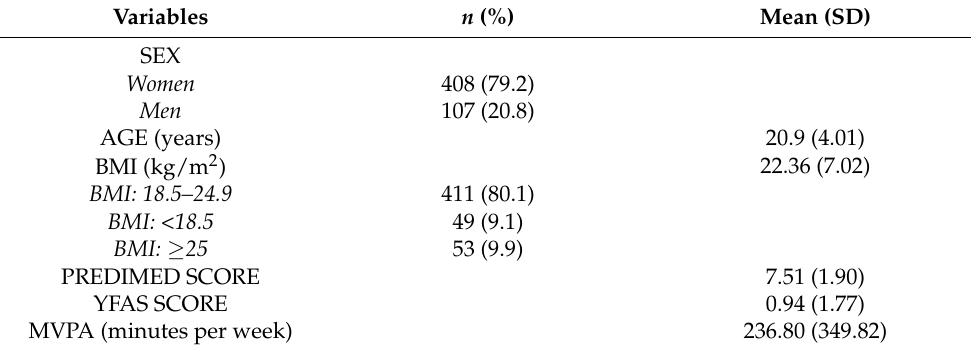
Table 1. Descriptive statistics of the sample analyzed.